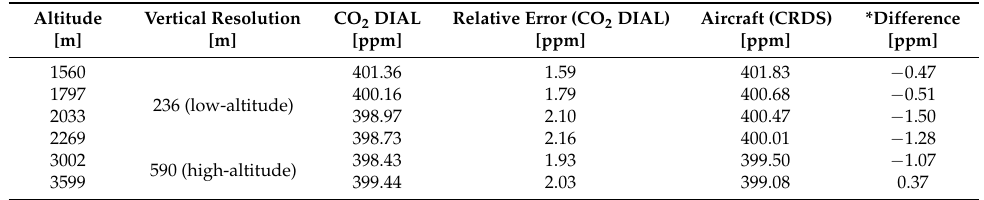
Table 2. Comparison of CO 2 mixing ratio derived from CO 2 DIAL and aircraft measurements. (*Difference: DIAL − aircraft).